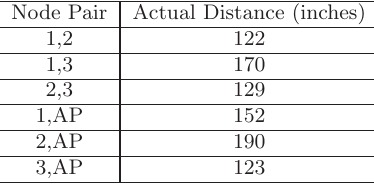
Table 3: Outdoor Pairwise distance by physical mea- surements Most of the time, drift and offset are quite stable within a small range. When there are adjustments or deviations in the clock, they will jump a lot. This is shown in Fig.6. That’s the reason why we need to determine drifts and off- sets in different rounds, but not a single constant across time.